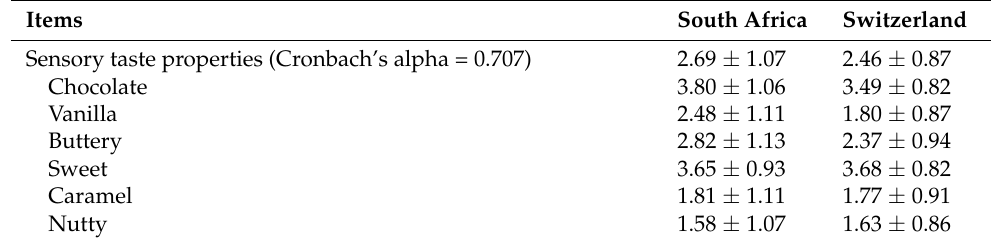
Table 5. Mean and standard deviation (m ± sd) values of consumers’ attitudes towards